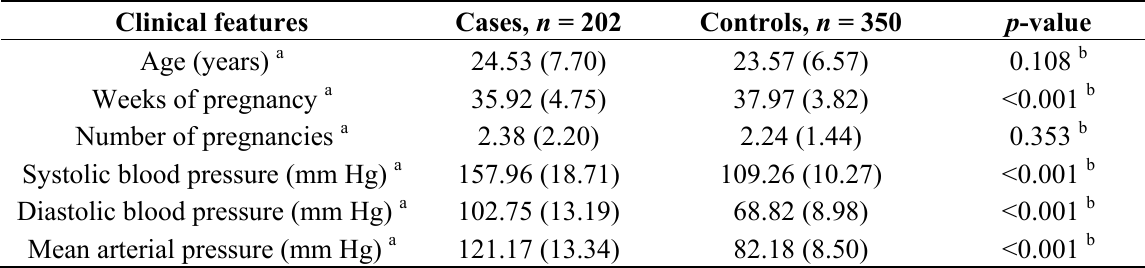
Table 1. Clinical characteristics of preeclamptic (cases) and healthy pregnant women (controls).